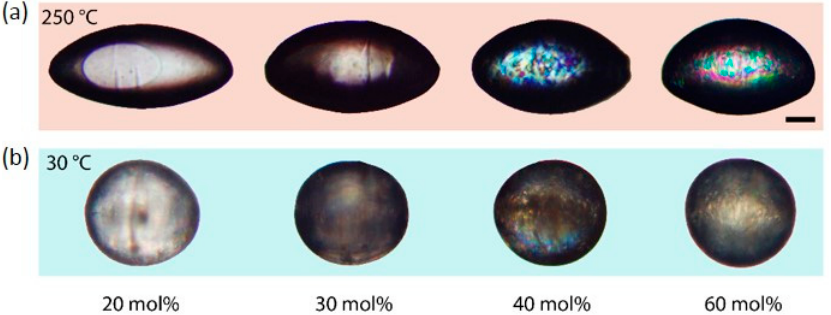
Figure 4. Shape transformation of LCE particles in the temperature range of 30 °C ( b ) and 250 °C ( a ). The particles contain different amounts of the liquid crystalline diacrylate crosslinker and were synthesized under the same microfluidic conditions (images were taken between crossed polarizers, scale bar: 100 µm).